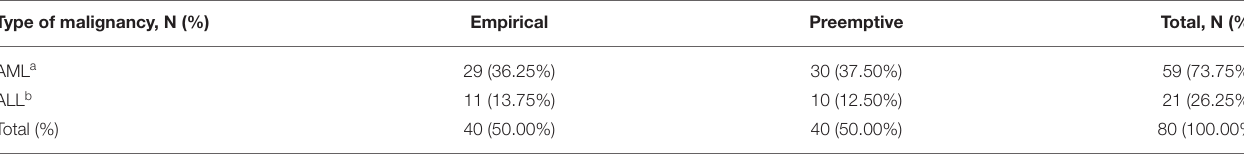
TABLE 1 | Distribution of empirical and preemptive therapy in 80 leukemic patients. Type of malignancy, N (%)